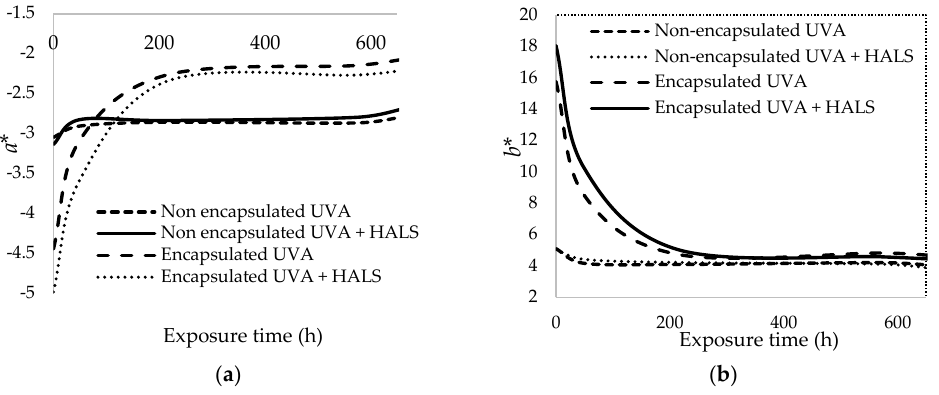
Figure 11. Evolution of ( a ) a *and ( b ) b * for the different formulations on glass panels with Weather- Ometer exposure.